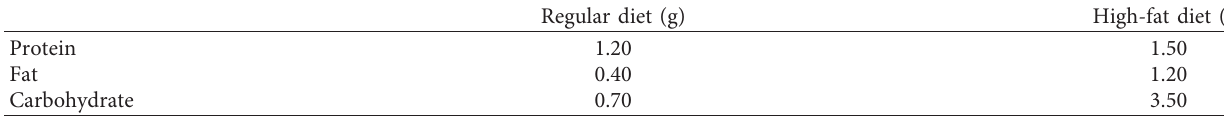
Table 1: The composition of a regular diet and HFD per 10 g